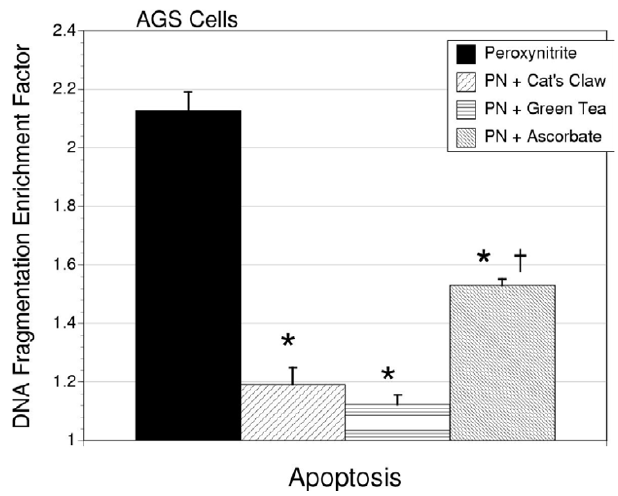
Figure 6 Apoptosis, measured as by histone-associated cytosolic DNA fragmentation, in AGS cells treated with peroxynitrite (300 µ M) alone or in combination with cat's claw, green tea extract or ascorbic acid (10 µ g/ml). All antioxidants reduced the extent of apoptosis ( * P < 0.01). However, ascorbic acid was significantly less effective than either cat's claw or green tea extract (P < 0.01).